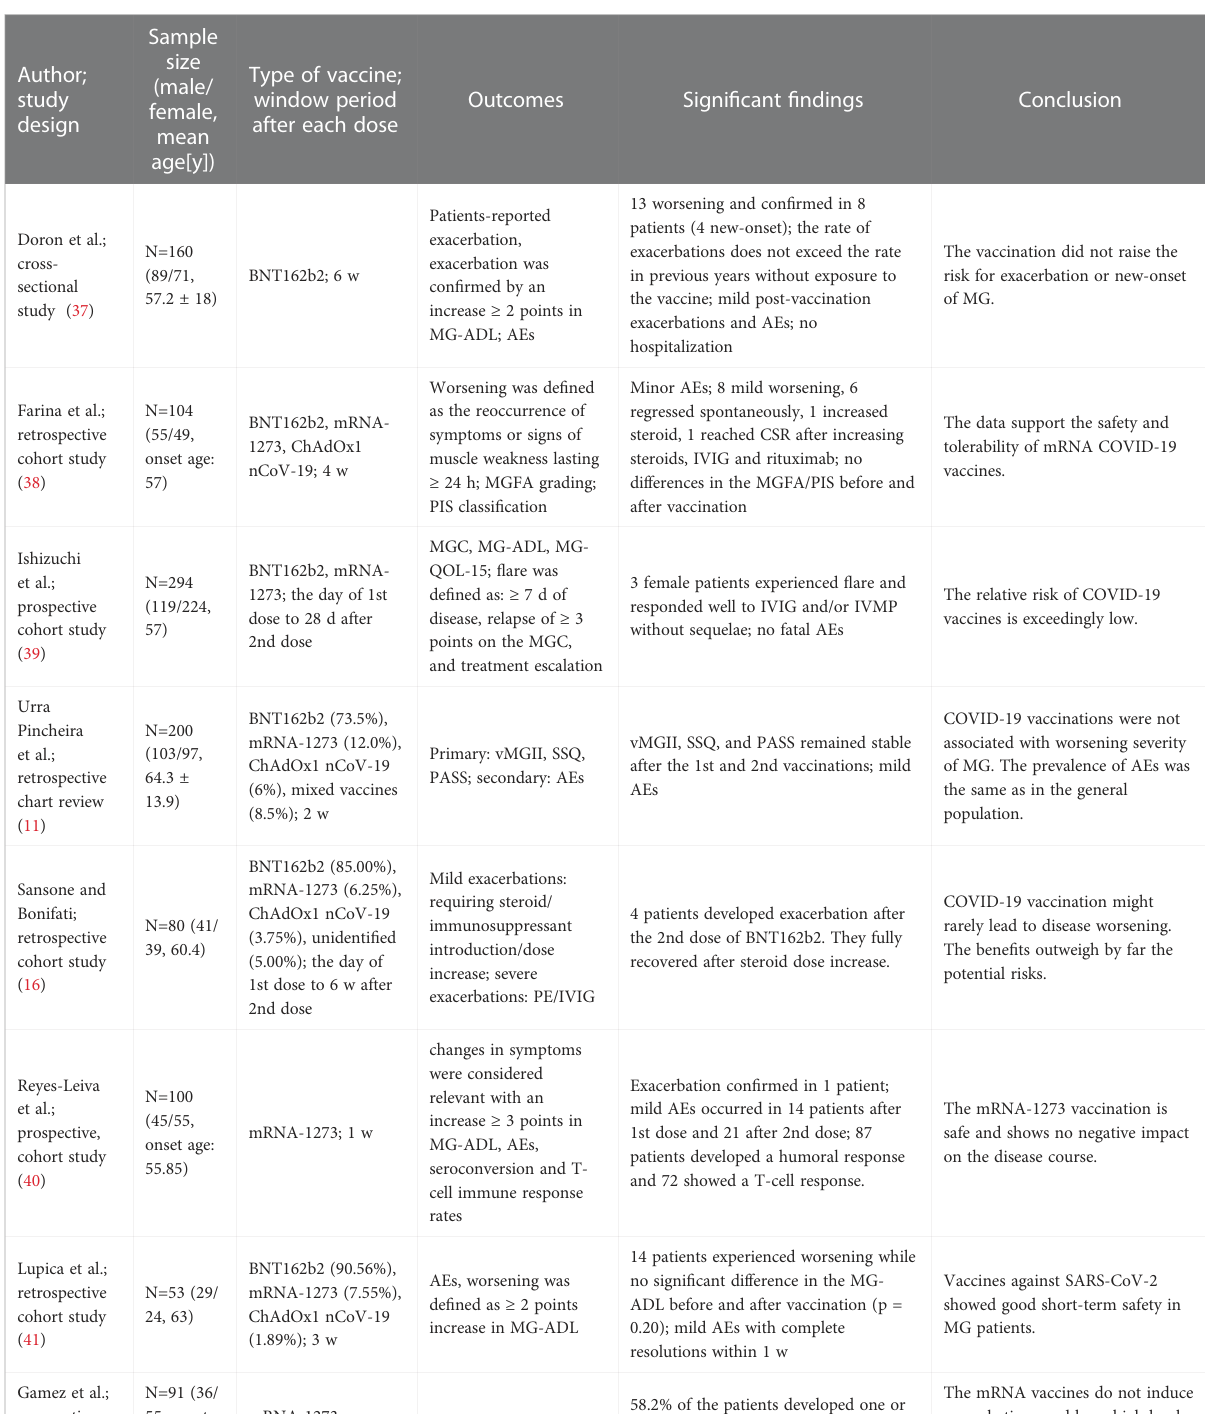
TABLE 4 Detailed information of other